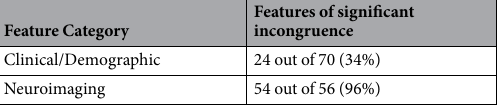
Table 3. Some of the clinical/demographic variables and many of the neuroimaging features exhibit significantly different distributions between the two